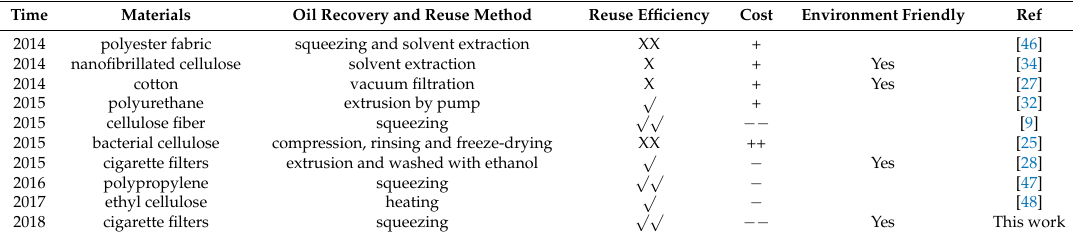
Table 1. Comparison of various fiber absorbents developed in recent years a .